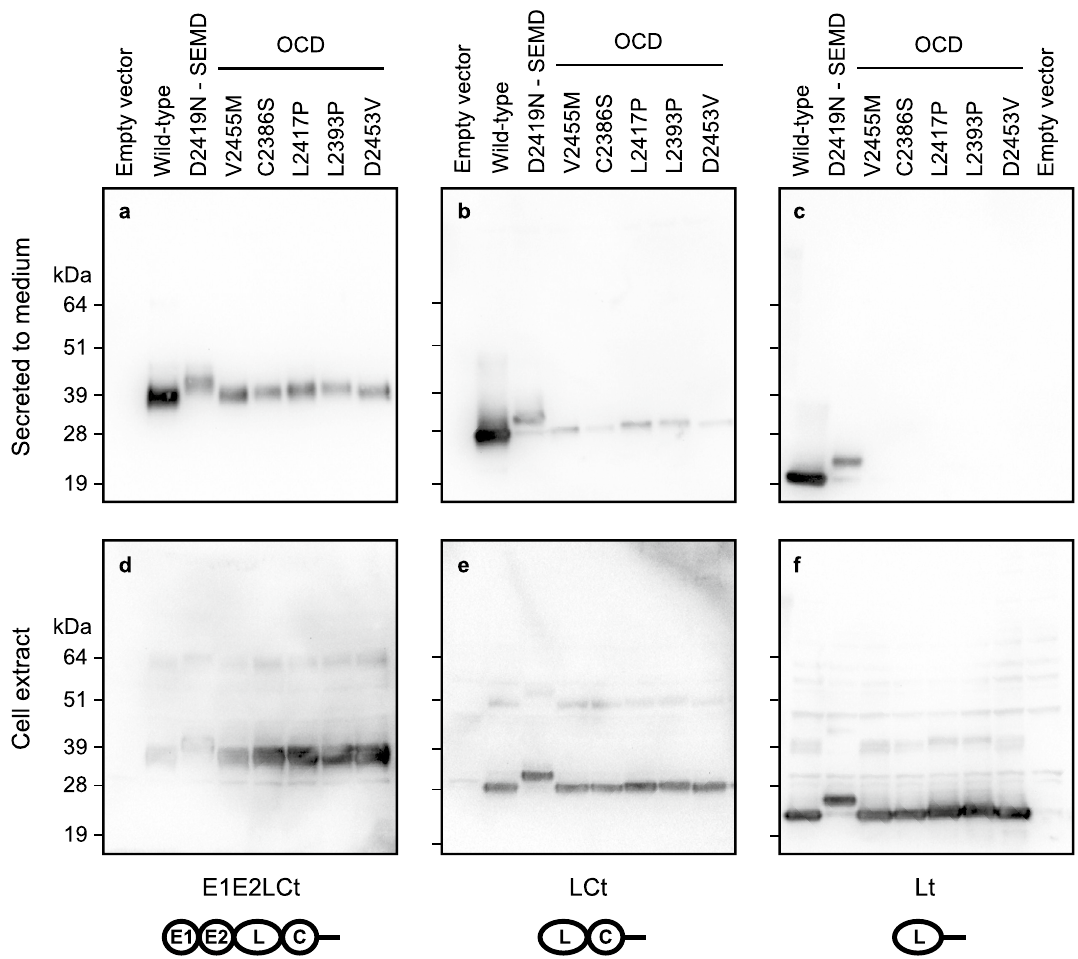
Figure 5. Secretion of recombinant aggrecan variant G3 domain protein. Expression plasmids for aggrecan SEMD and fOCD gene variants were transfected into human 293-c18 cells. Recombinant protein was recovered from culture medium ( a – c ) and cell lysates ( d – f ), and analyzed by immunoblotting. Each gene variant was tested in three different constructs corresponding to aggrecan G3 domain splice-forms; full-length E1E2LCt ( a , d ), C-type lectin and complement regulatory/sushi repeat LCt ( b , e ) and C-type lectin alone Lt ( c , f ). The domain arrangements of the G3 splice-forms tested are shown schematically at the bottom of the figure. As shown in ( d , e) , all gene variants in all splice-forms tested were produced. Secretion of variant full-length G3 domain E1E2LCt was somewhat decreased compared to wild-type ( a ), while secretion of fOCD variants as LCt protein was strongly decreased ( b ). No secretion of any fOCD variant Lt protein, i.e. the C-type lectin alone, was observed ( c ). Note that the SEMD variant p.D2419N protein was secreted in all splice-forms, although at lower levels than wild-type protein ( a – c